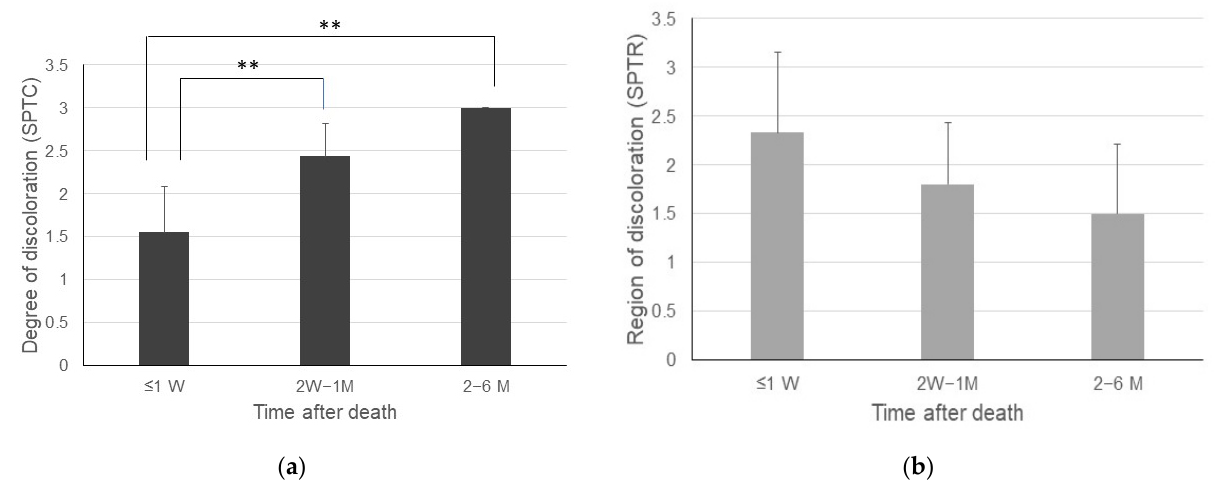
Figure 7. Association of SPTC ( a ) and SPTR ( b ) with time after death in drowning cases (18 cases, n = 2–10). ( a ) SPTC between 2 weeks and 1 month and for 2–6 months showed significant increases compared with ≤ 1 week ( p < 0.01); ( b ) Although there were no significant differences, SPTR tended to decrease with time after death. ** p < 0.01. SPTC, Score of Pink Teeth Color; SPTR, Score of Pink Teeth Region.